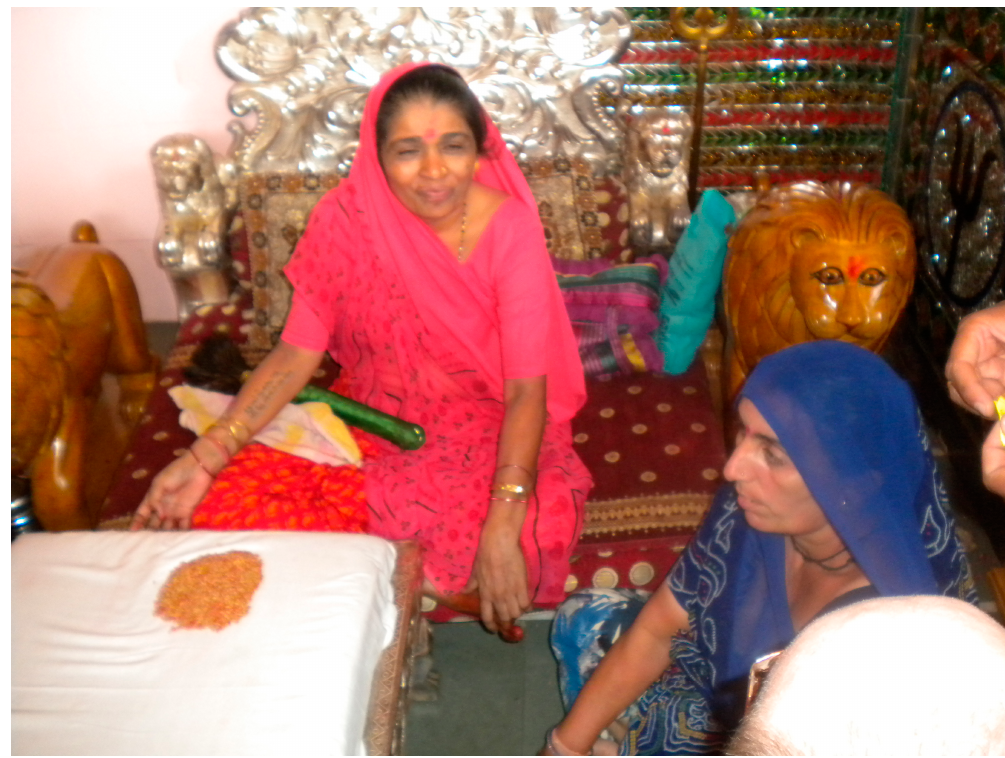
Figure 3. Maa Laadchi (on left) sitting patla. Photo by author.